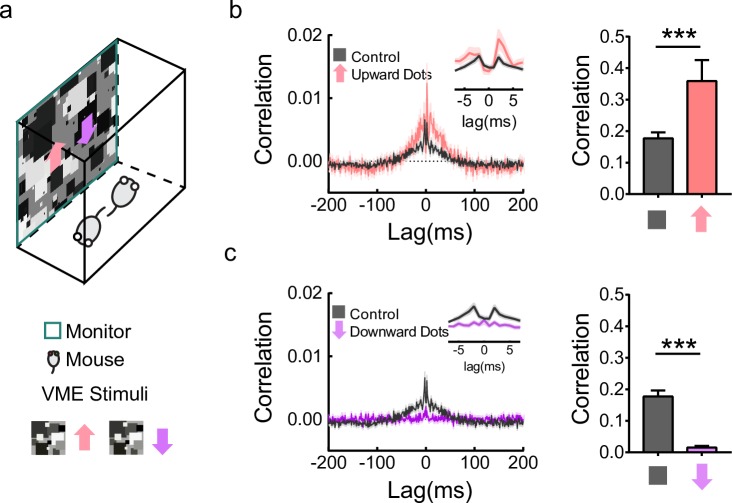
VME affected synchronized activity in V-DSGCs.(a) Diagram of the VME training (top) and the color codes for VME stimuli (bottom). For each stimulus, left, spatial pattern; right, color code with direction of motion. (b) Average cross-correlogram of V-DSGC pairs during travelling gratings stimulus (left) and quantification of correlation strength (right). Control, gray, n = 139 pairs of V-DSGCs; upward VME, pink, n = 51. Shaded areas, ±SEM. Insets are close-up views with 1-ms bin size. For correlation strength comparison, the sum of the spike time cross-correlation (left) from −100 ms to +100 ms at a bin size of 1 ms are used. ***p < 0.001, unpaired t test. Error bars, SEM. (c) The same as (b) but to compare the control group with the downward VME group. Control, gray, n = 139; downward VME, purple, n = 130. For correlation strength comparison, ***p < 0.001, unpaired t test. Error bars, SEM. Data for this figure are in S2 Data. DSGC, direction selective ganglion cell; VME, visual motion experience.